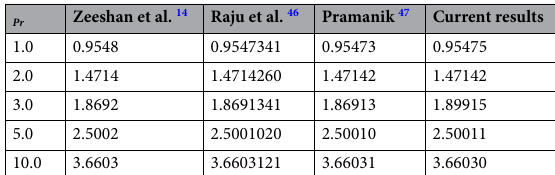
Pr Zeeshan et al. 14 Raju et al. 46 Pramanik 47 Current results